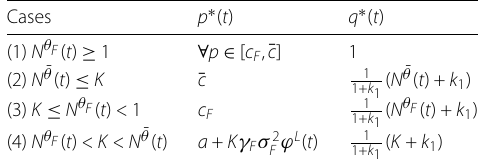
Table 1 The optimal premium and reinsurance strategies